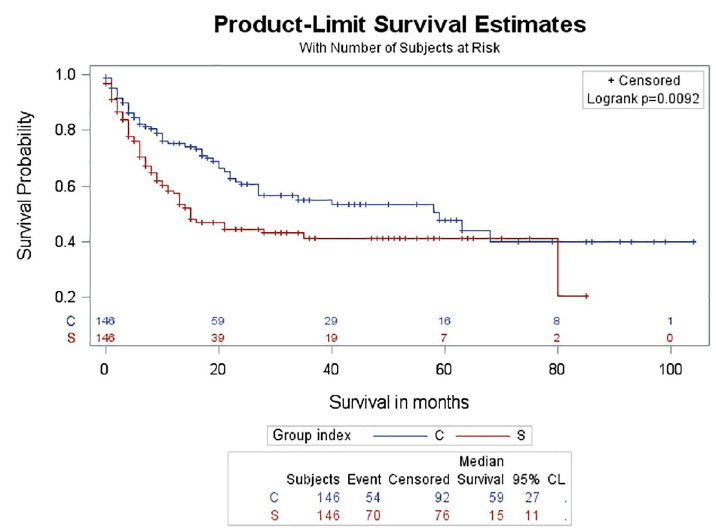
Fig 4. Survival curves for the study and control group. Survival curves for the study (S) group (red colour) and control (C) group (blue colour) (p = 0.0092).